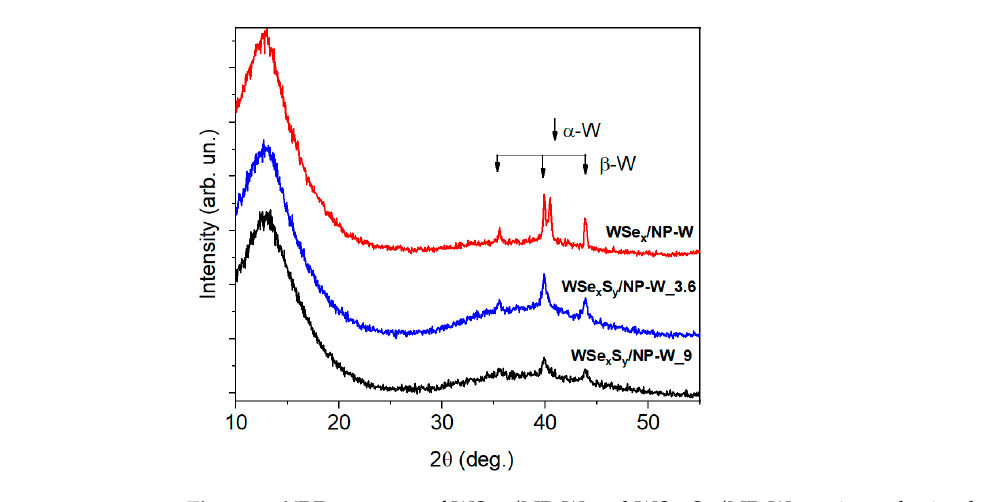
Figure 2. XRD patterns of WSe x /NP-W and WSe x S y /NP-W coatings obtained on Si substrates by PLD and RPLD at 3.6 and 9 Pa pressure of H 2 S gas.